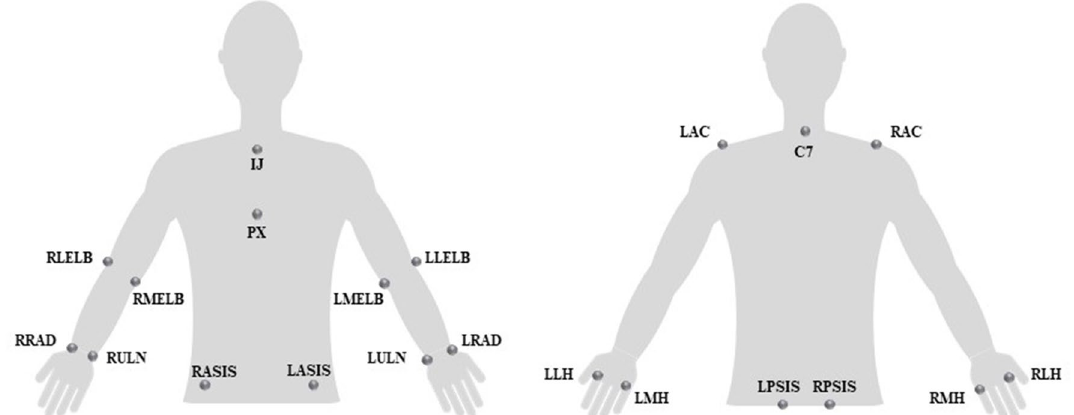
Figure 1. Anatomical references for reflective markers placement. C7 spinous process of the 7th cervical vertebra; IJ incisura jugularis, LAC middle part of left acromion, LASIS left anterior superior iliac spine, LLELB lateral epicondyle of left humerus, LLH lateral side of the head of the second left metacarpal, LMELB medial epicondyle of left humerus, LMH medial side of the head of the fifth left metacarpal, LPSIS left posterior superior iliac spine, LRAD styloid process of left radius, LULN styloid process of left ulna, PX processus xiphoideus, RAC middle part of right acromion, RASIS right anterior superior iliac spine, RLELB lateral epicondyle of right humerus, RLH lateral side of the head of the second right metacarpal, RMELB medial epicondyle of right humerus, RMH medial side of the head of the fifth right metacarpal, RPSIS right posterior superior iliac spine, RRAD styloid process of right radius, RULN styloid process of right ulna.